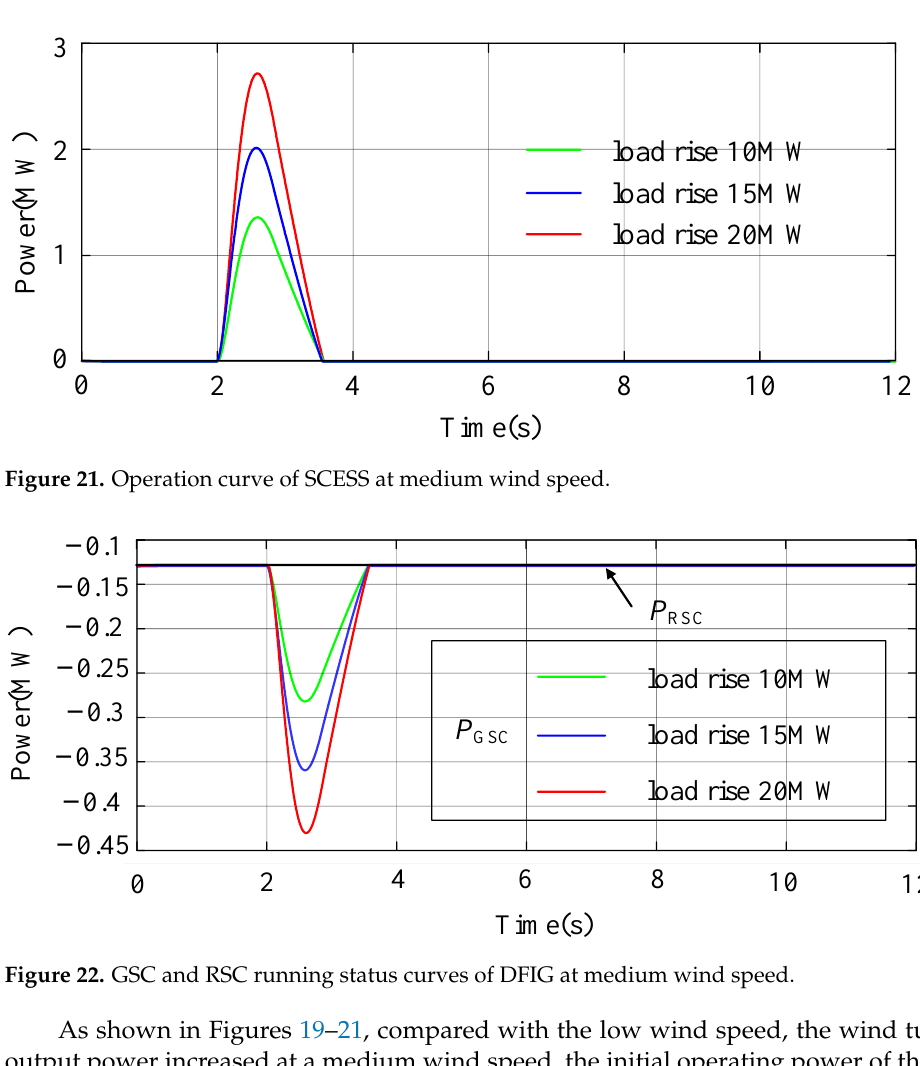
All three groups of the SCESS-DFIGs were set to work at a high wind speed, and the wind speed was 12 m/s. The surge load was added at 2 s, and its values were 10 MW, 15 MW and 20 MW, respectively. The system frequency regulation curve, the P2H and SCESS operation curves, and the GSC and RSC running status curves of the DFIG are shown in Figures